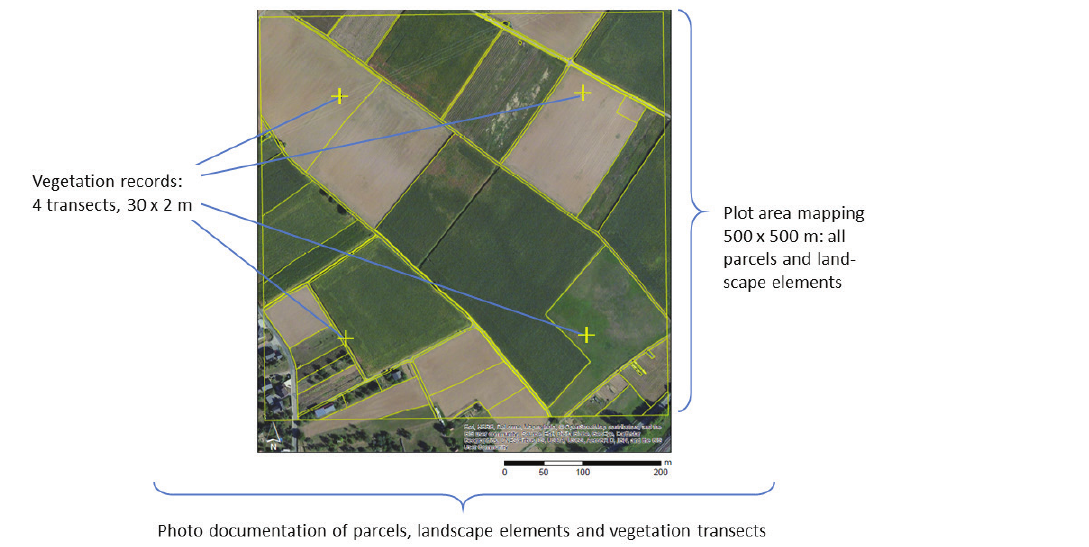
Figure 1. The three elements of the monitoring design: plot area mapping on a square of 500 m x 500 m, 4 vegetation transects and photo documentation. The identification points for the vegetation transects are situated at 100 m distance from the nearest edge lines of the plot. The photo documentation comprised photos of the transects and at least one overall plot photo as well as further photos of parcels and landscape elements (see